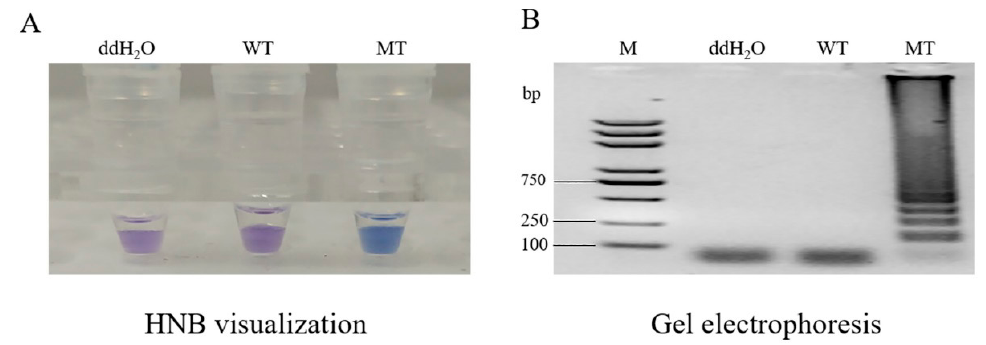
Figure 4. Screening of specific primers for LAMP reaction. M. Trans 2K Plus DNA marker. WT and MT indicated the genome- CsRDL1 -A282 and Blunt- CsRDL1 -S282, respectively.